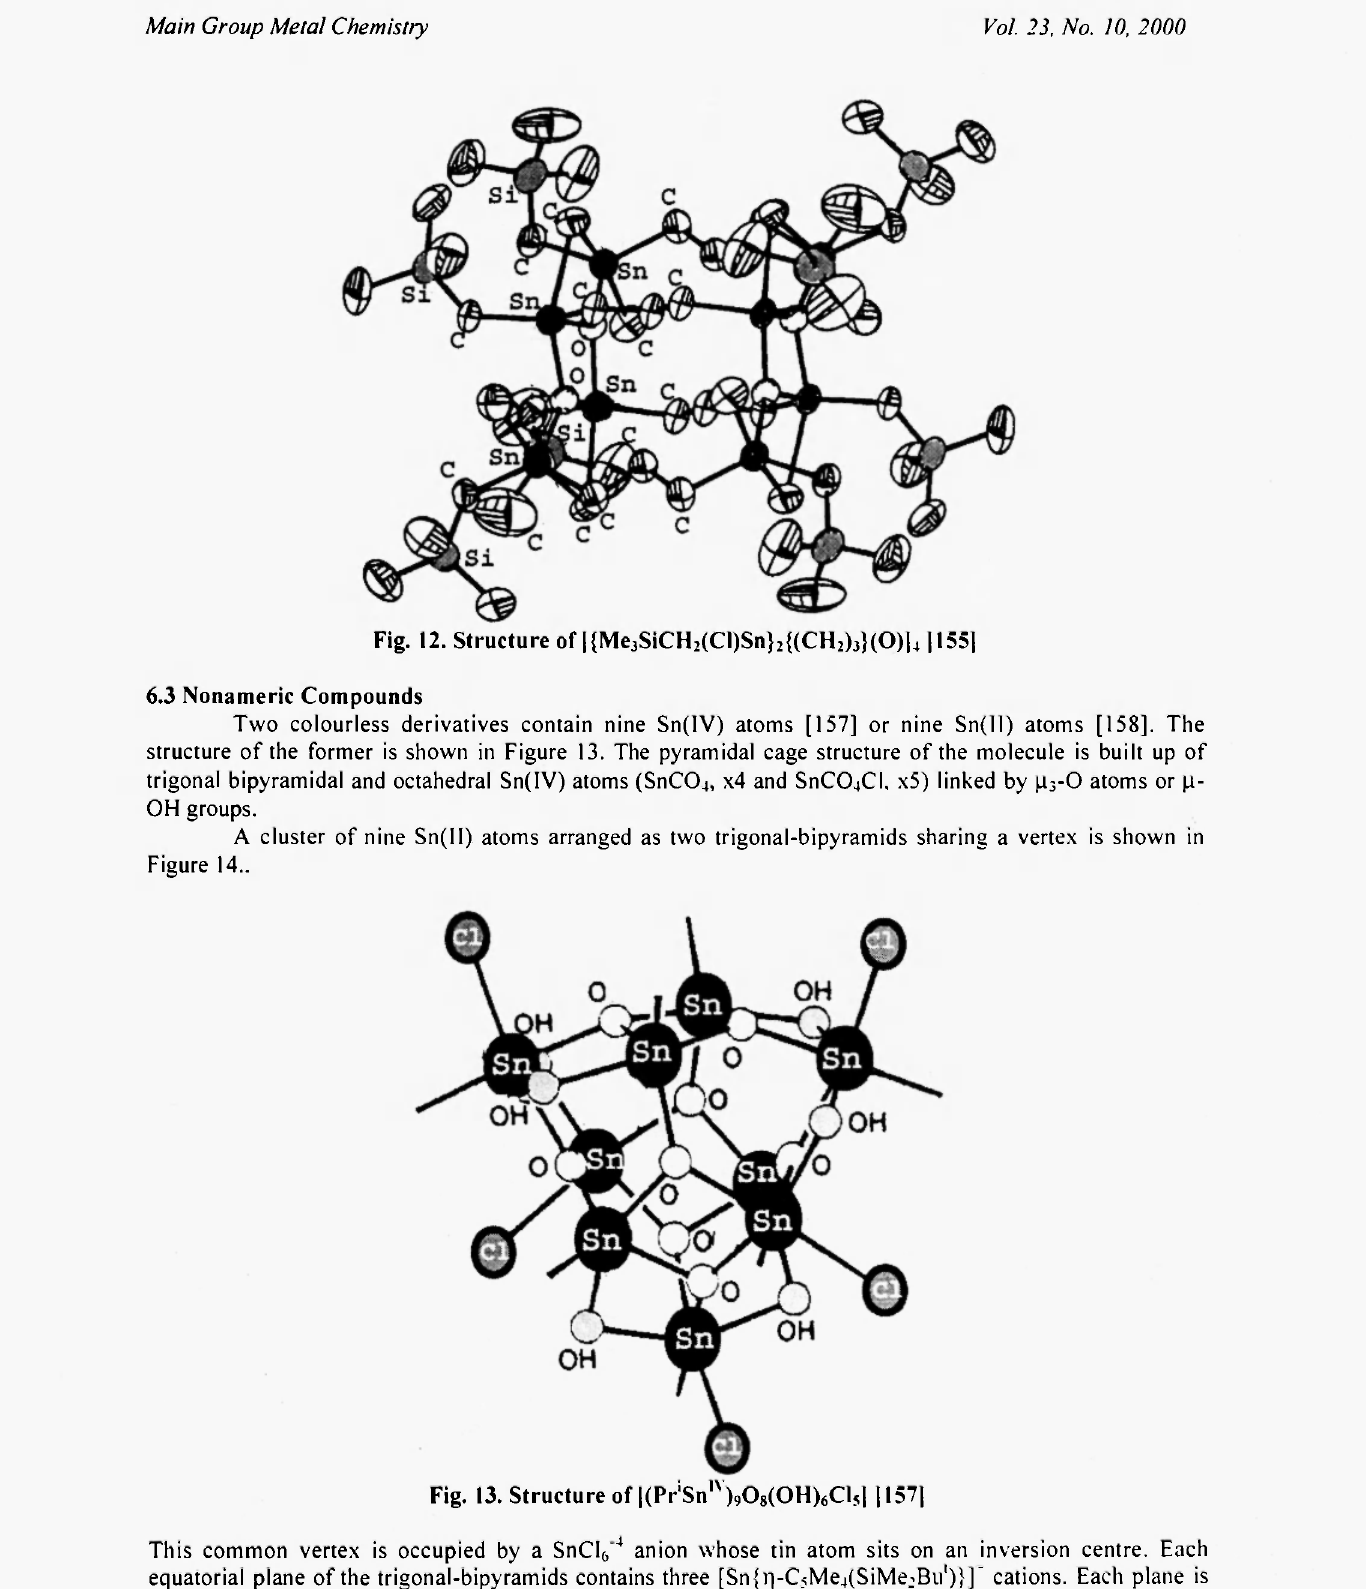
Fig. 13. Structure of |(Ρι· ! 8η%08(0Η) 6 €Ι 5 |